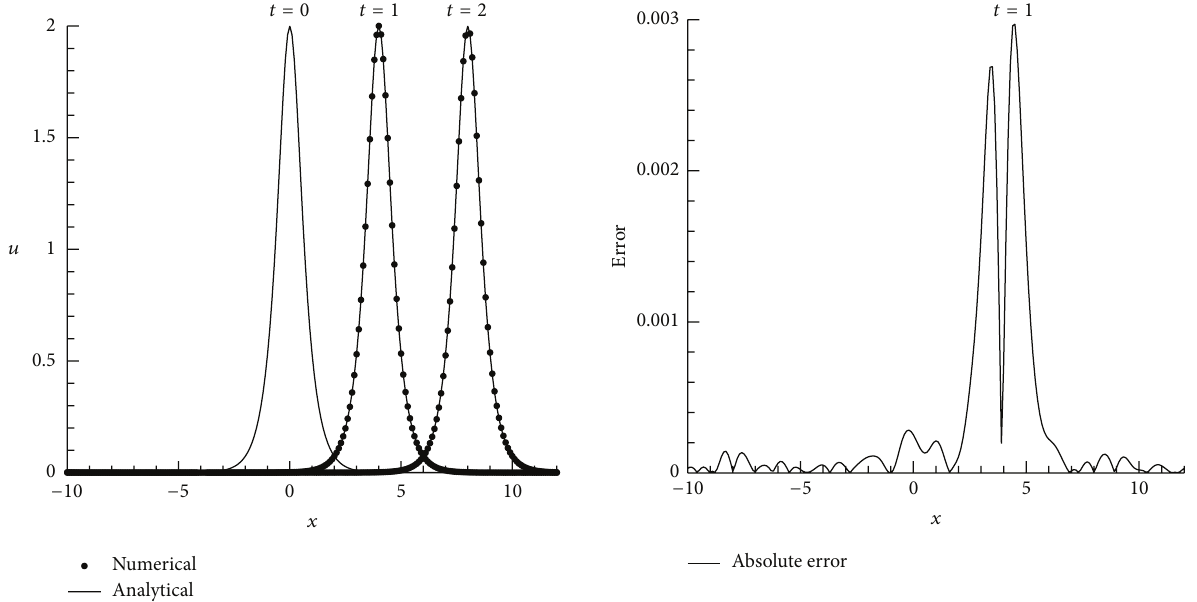
Figure 2: Numerical and analytical solutions (line) for equation 𝑢 𝑡 + 6𝑢 2 𝑢 𝑥 + 𝑢 𝑥𝑥𝑥 = 0 of Example 3 at various time stages and the absolute error for 𝑡 = 1 .